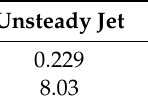
Table 1. Drag coefficient reduction with different actuator types.